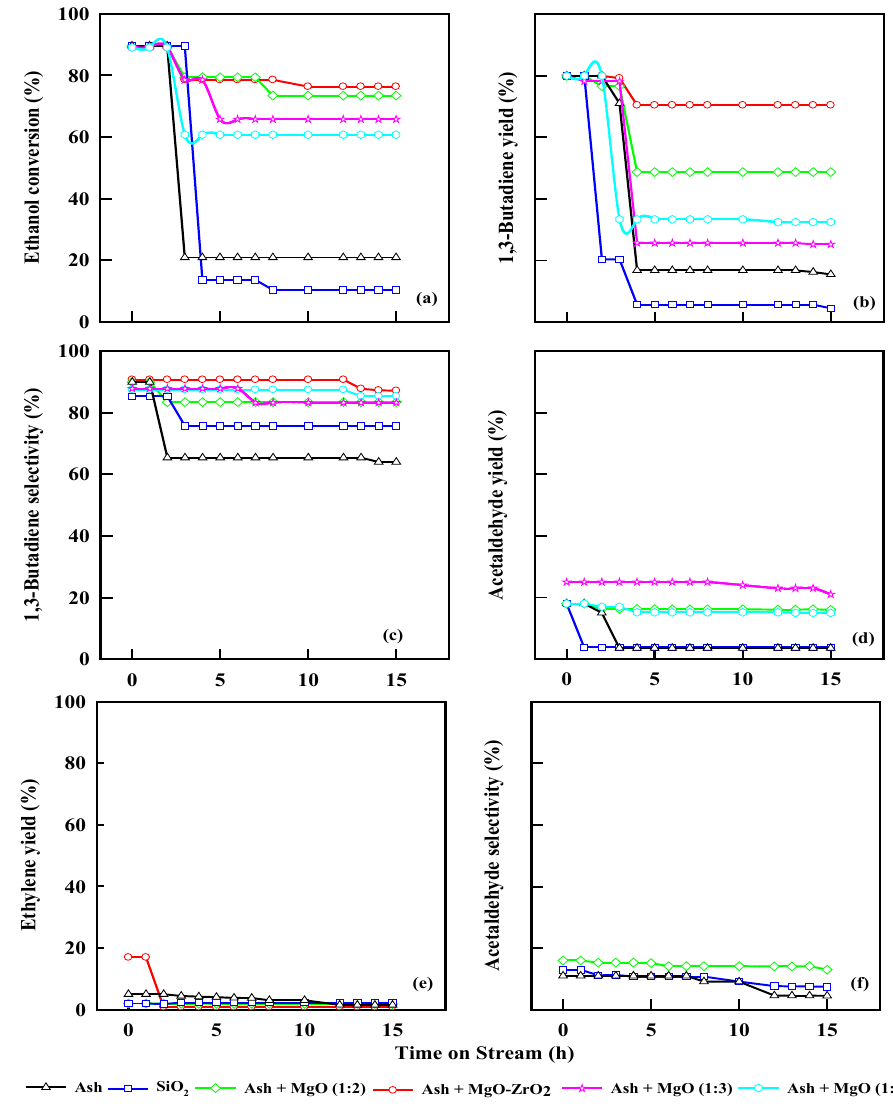
Figure 10. Conversion of ethanol for the ( a ), yield of 1,3-butadiene ( b ), selectivity of 1,3-butadiene ( c ), yield of acetaldehyde ( d ), yield of ethylene ( e ), and selectivity of acetaldehyde ( f ) with time on streams. WHSV: 2.5 h −1 , 0.4 g of catalyst, N 2 = 30 mL/min, Temp: 350 °C.